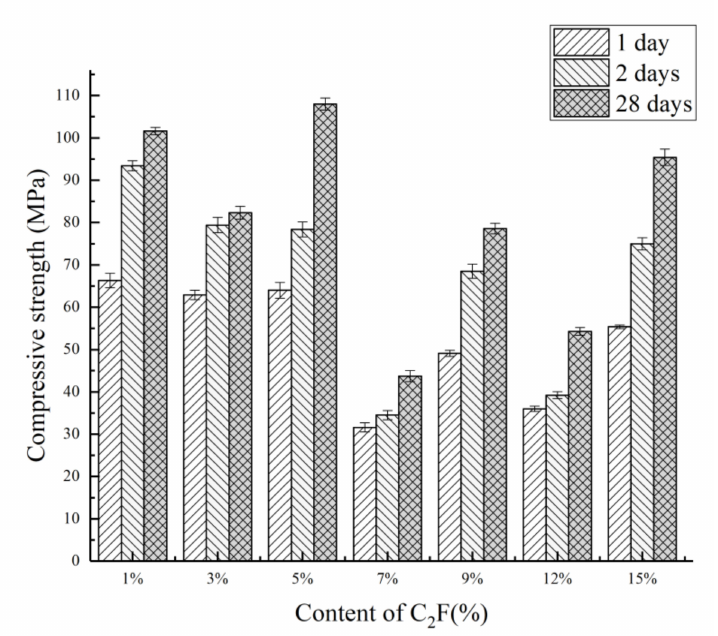
Figure 12. Compressive strength of the clinker at 1350 ◦